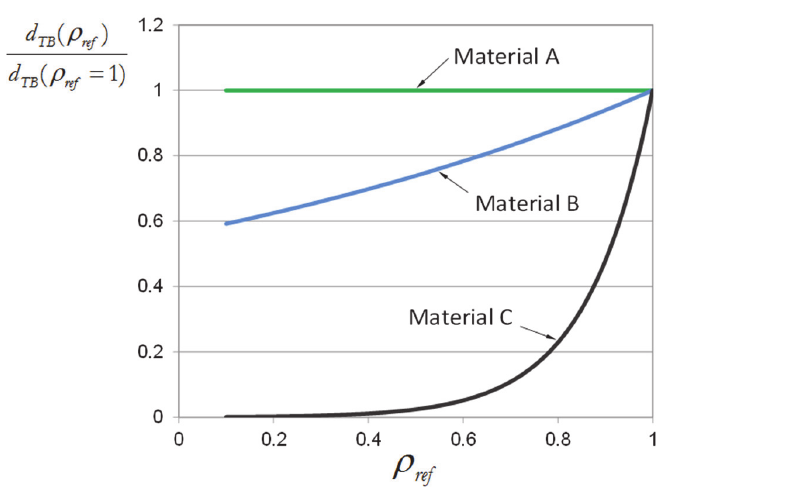
Figure 5: Effect of hydrostatic stress on fatigue damage for different materials undergoing a tension-torsion loading with C s1 + C s3 =